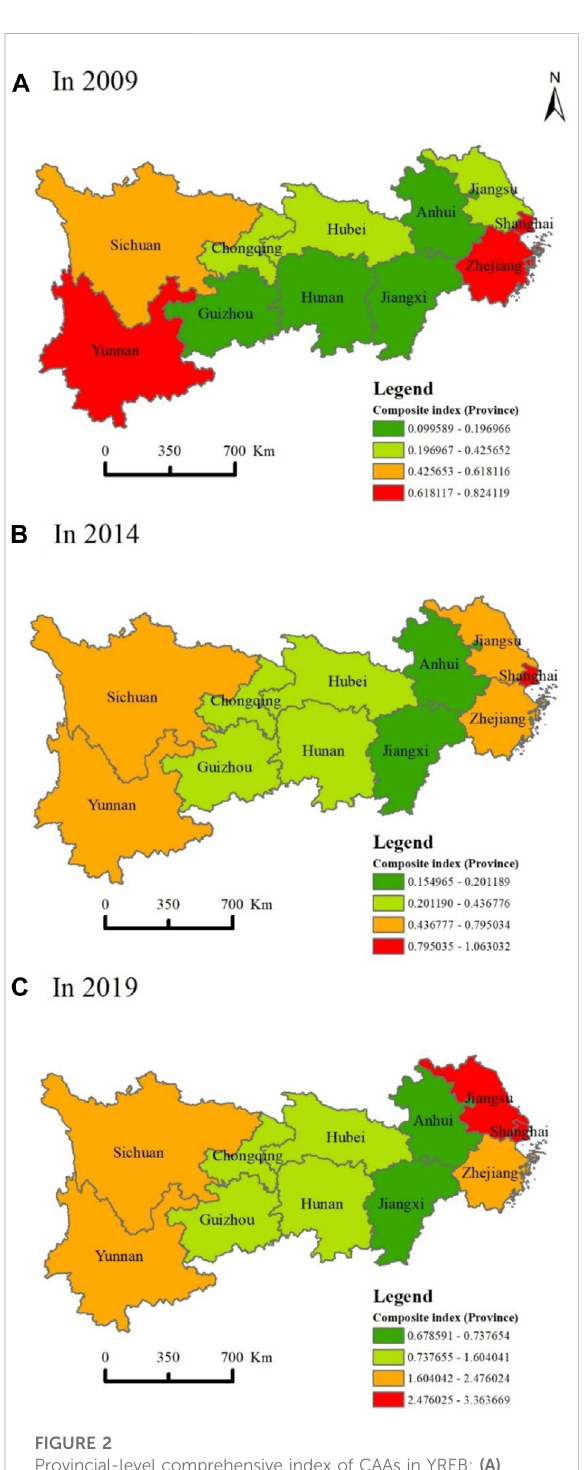
FIGURE 3 ThecompositeindexoftheCAAsinYREB. (A) 2009; (B) 2014; (C)